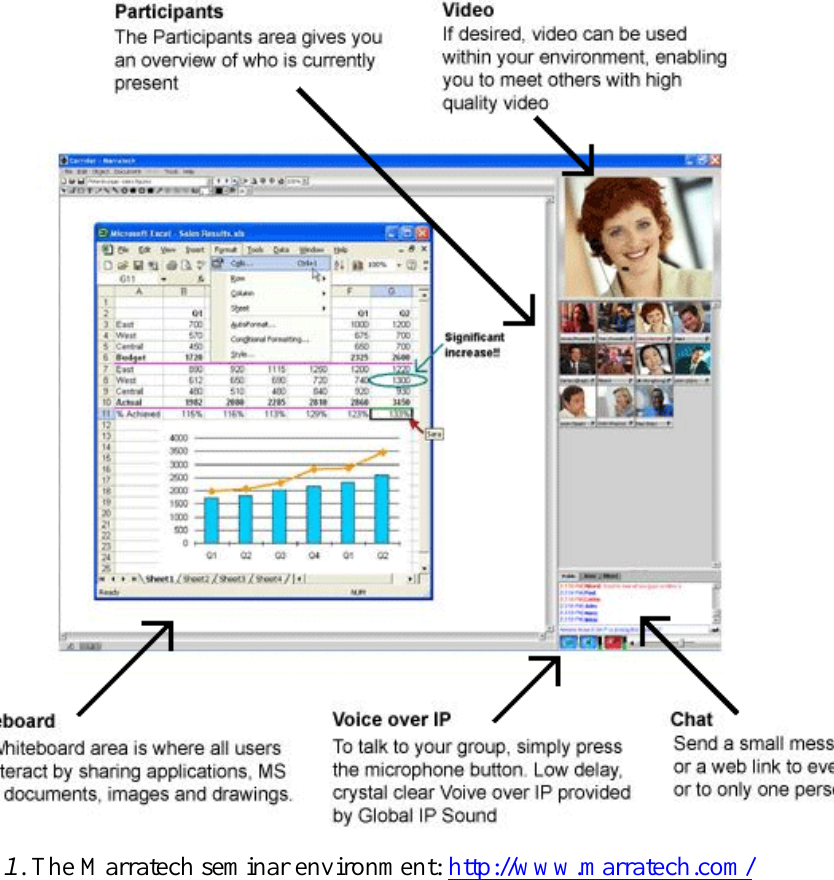
Figure 1 . The Marratech seminar environment: http://www.marratech.com/